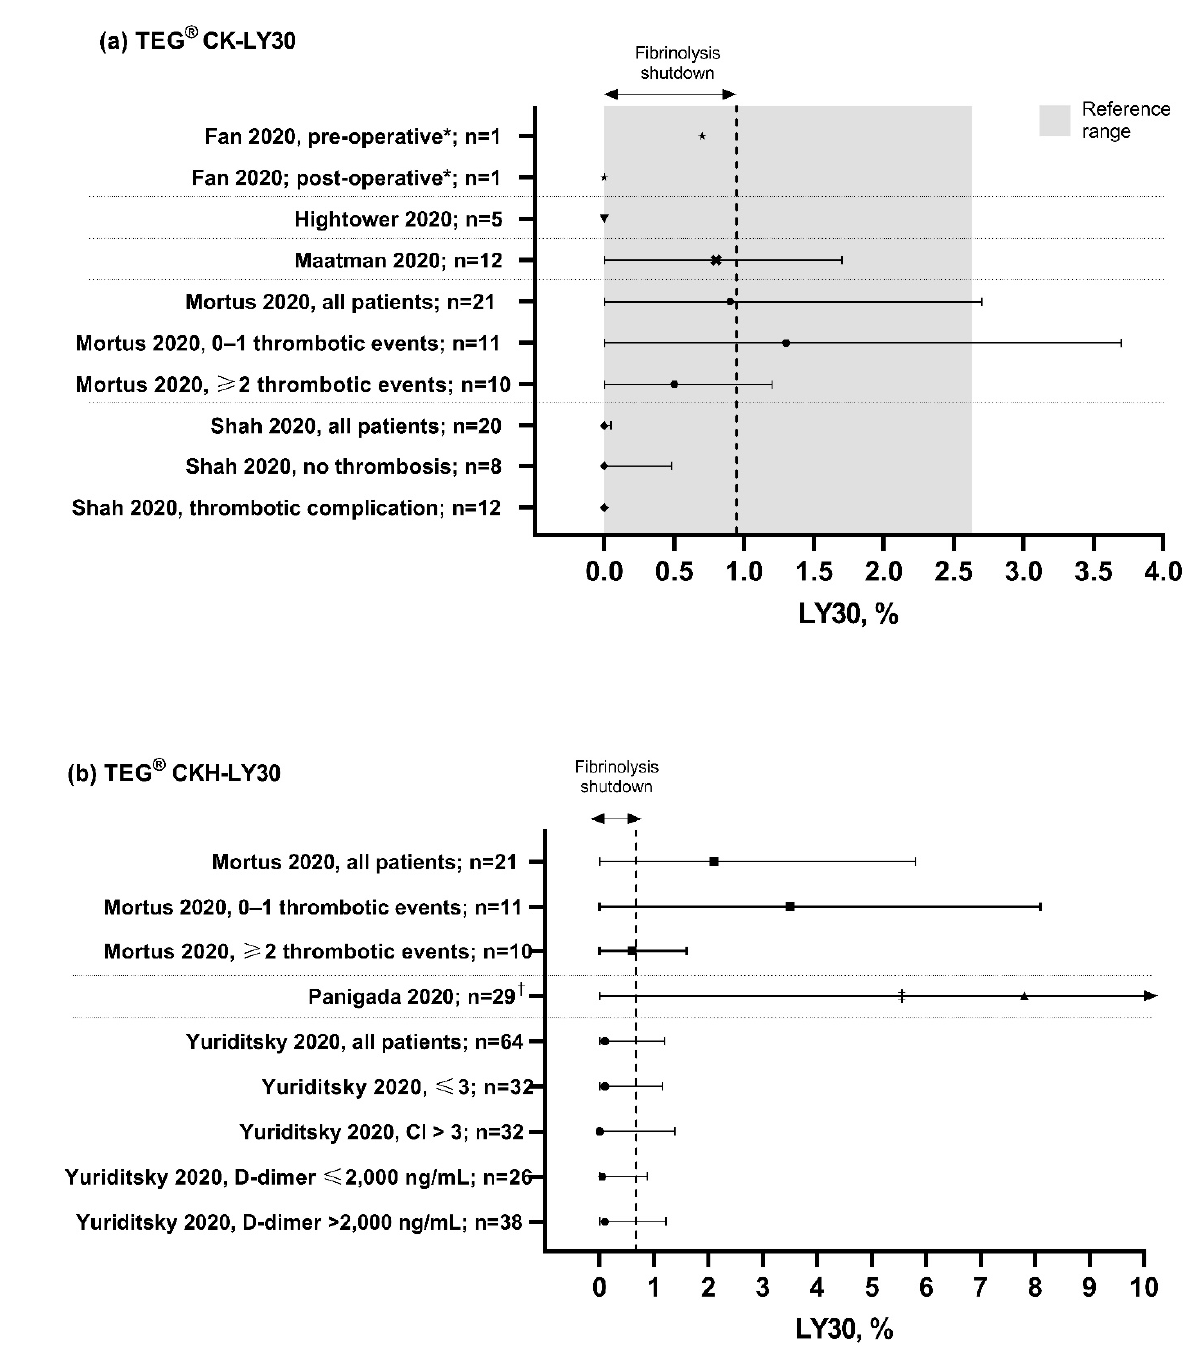
Figure 3. TEG LY30 values observed in patients with COVID-19. Grey bar shows the normal TEG reference range [10]. CK, citrated kaolin assay; CKH, CK with heparinase assay; LY30, clot lysis at 30 min after maximum clot strength. * TEG measurements recorded before and after endovascular stent graft exclusion of the aortic thrombus and right lower limb embolectomy following diagnosis of acute ischemic limb. † Measurements were repeated on two consecutive days in six patients. ‡ LY30 range reported: 0–54.3%. Data points are mean with standard deviation error bars for normally distributed data, or median with interquartile range error bars for data that were not normally distributed. Dotted lines separate different studies with different patient populations. Data are not directly comparable between